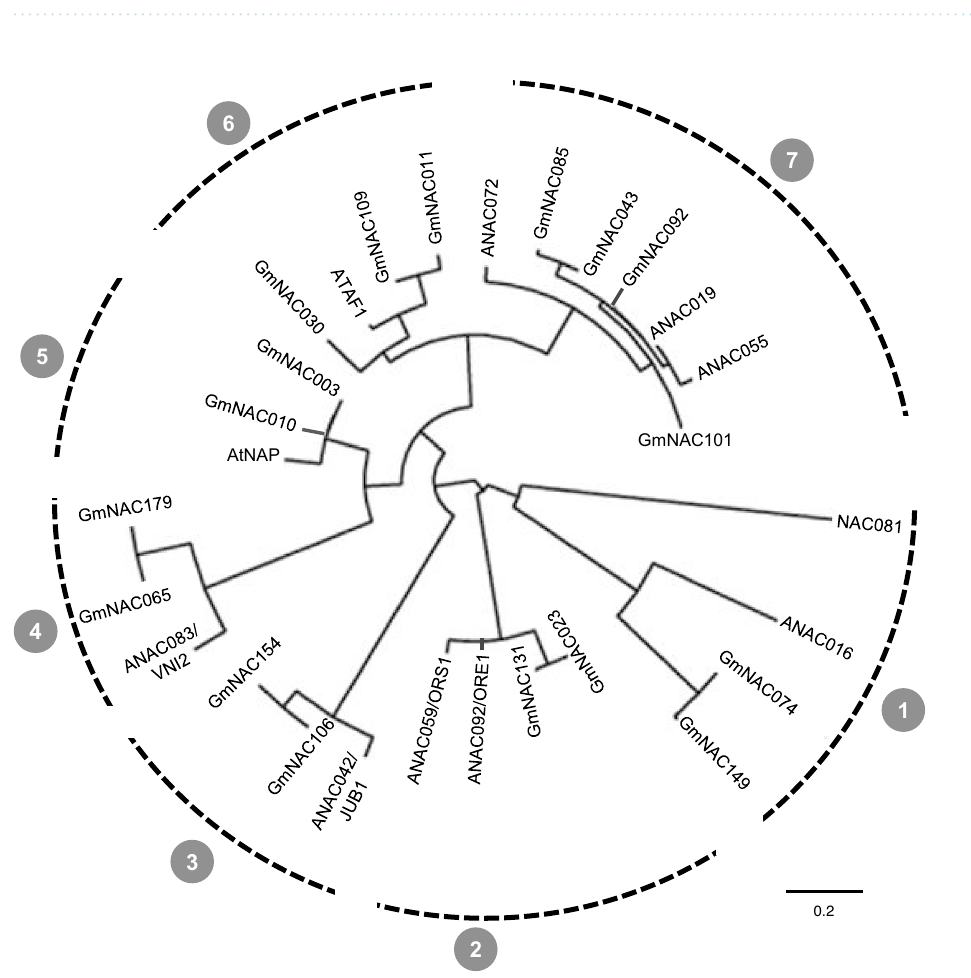
Figure 1. Phylogenetic reconstruction of Arabidopsis thaliana and soybean ( Glycine max ) NAC-SAGs. The deduced amino acid sequences of previously described NAC-SAGs of Arabidopsis were used as prototypes to retrieve their putative orthologous genes ( Gm NAC-SAGs) from the soybean genome. The phylogenetic reconstruction resulted in seven distinct groups with stable collapsed branches. Phylogenetic relationships were established by the neighbor-joining statistical method with 10,000 bootstraps, and the tree was rendered using the MABL